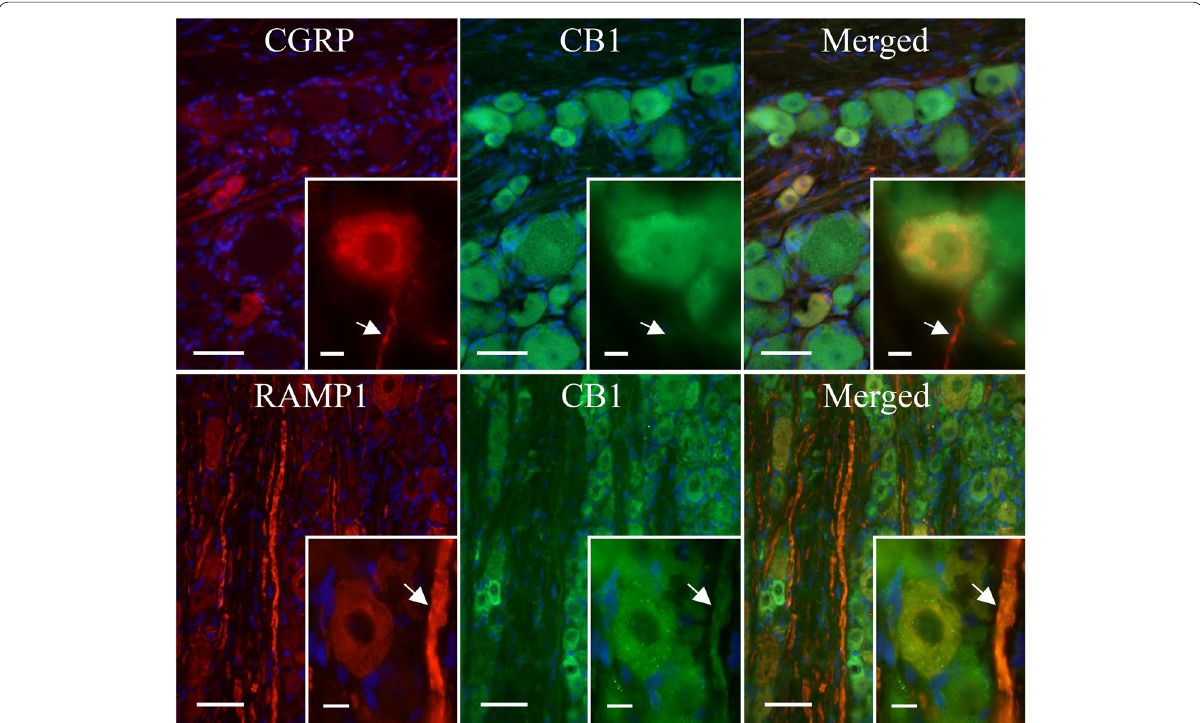
Fig. 4 The expression of CB1, CGRP and RAMP1 in the TG. IHC localization of CB1, CGRP and the functional CGRP receptor (by staining for RAMP1) in the TG. Blue represents cell nuclei; orange represents colocalization of CGRP (upper panel) or RAMP1 (lower panel) with CB1; globular regions represent neuronal somas and fibrous regions represent individual neuronal fibres. Large image scale corresponds to 50 mm, and the insert scale corresponds to 10 μm. The arrows mark unmyelinated C-fibres (upper panel) and myelinated Aδ-fibres (lower